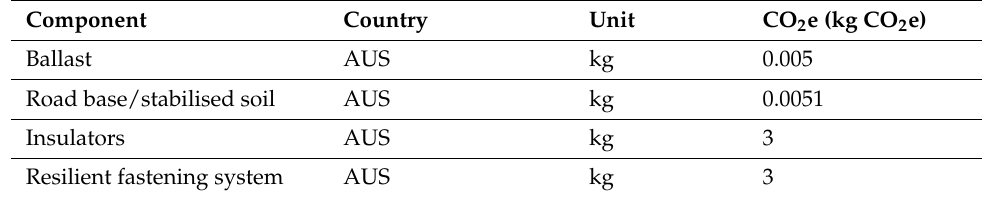
Table 3. The embodied CO 2 e factors (f)